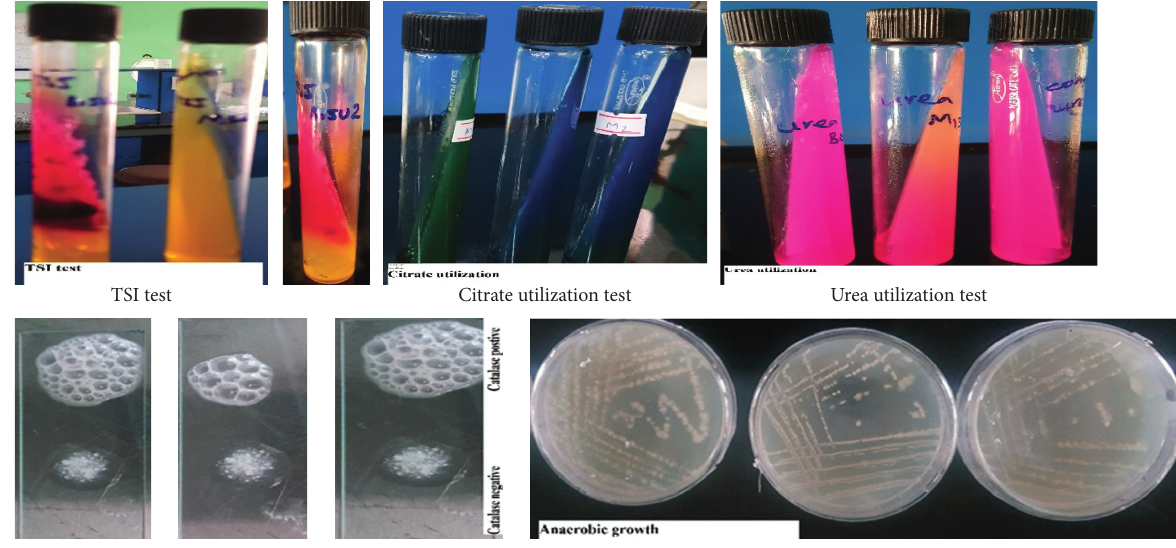
Figure 3: Results of some of the biochemical tests performed.